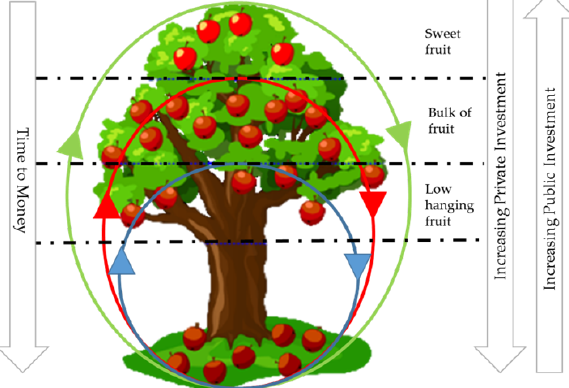
Fig. 1 . IdeaSquare set-up ecosystem illustrating its innovation dynamics cycles (short = low hanging fruits, mid = bulk of fruit, long = sweet